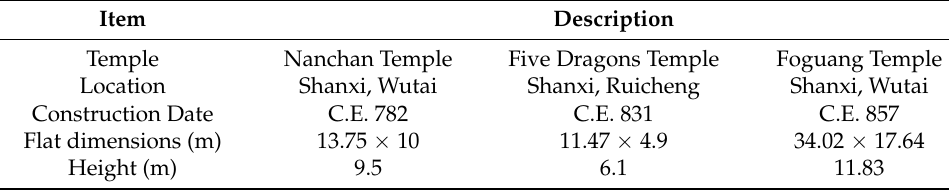
Table 1. General description of the comparison of the halls *. Item